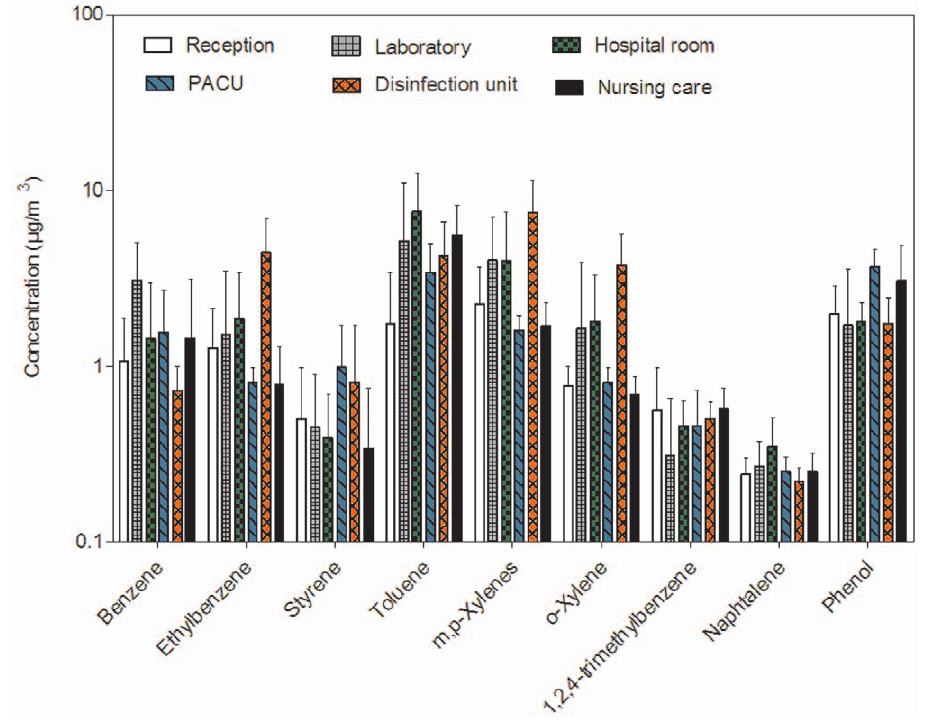
Figure 1. Comparison of aromatic hydrocarbons concentrations (arithmetic mean ± SD on a logarithmic scale) in the six sampling sites.